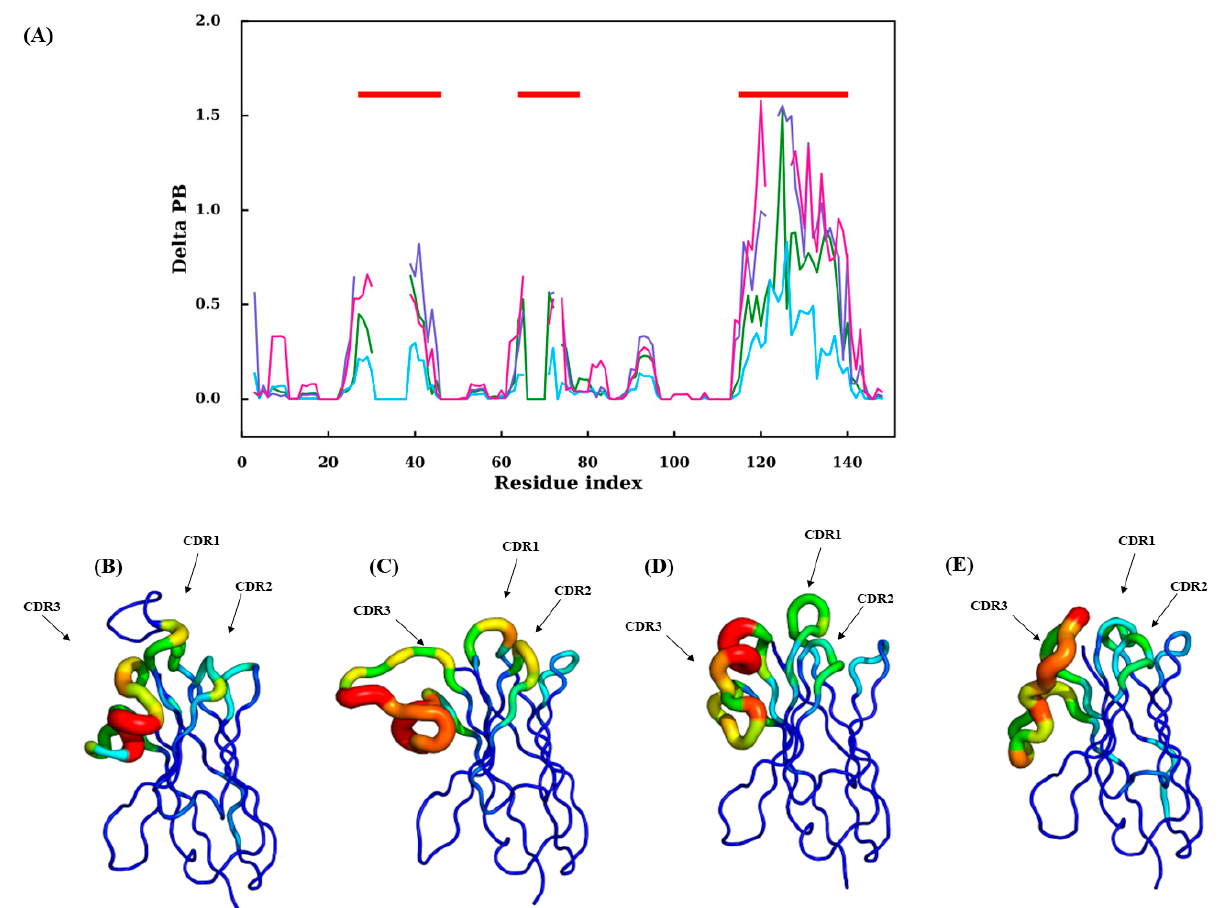
Figure 8. PBs’ differences in terms between each RMSF cluster. ( A ) Δ PB (with RMSF cluster 1 in sky blue, with RMSF cluster 2 in green, with RMSF cluster 3 in purple and with RMSF cluster 4 in pink); CDRs are shown with red line. 3D visualisation on structures of Δ PB values for ( B ) RMSF cluster 1, ( C ) RMSF cluster 2, ( D ) RMSF cluster 3, and ( E ) RMSF cluster